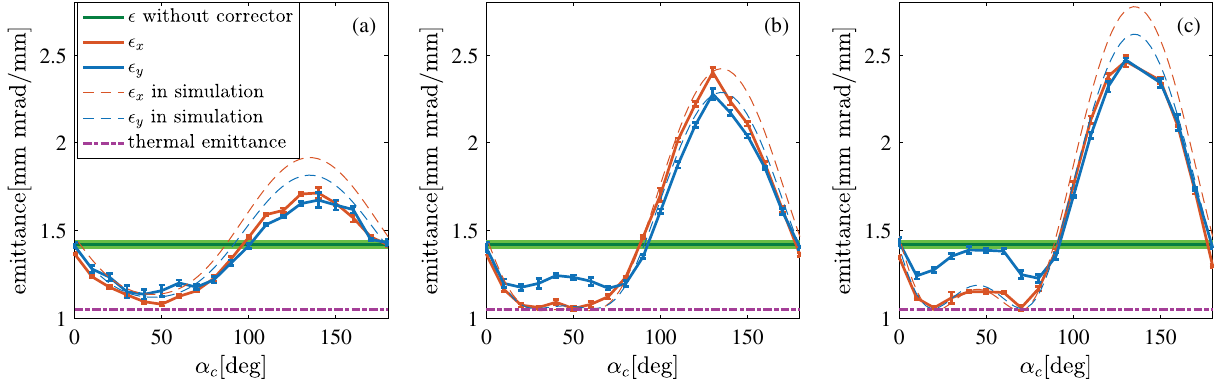
FIG. 3. Measured transverse emittance for a 2.7 mm rms laser spot size as a function of the quadrupole corrector ’ s strength and rotation angle. The green line represents the emittance without the corrector, and its width denotes the measurement error bar. The dashed magenta line represents the thermal value. The corrector strength in (a) – (c) is 36, 72, and 96 G = m, respectively.